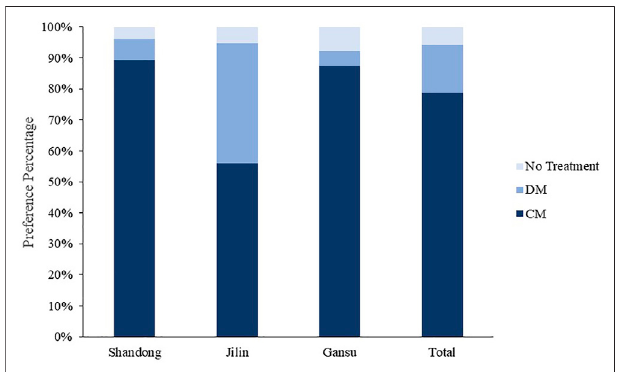
FIGURE 2 | Distribution of the respondents ’ preference for